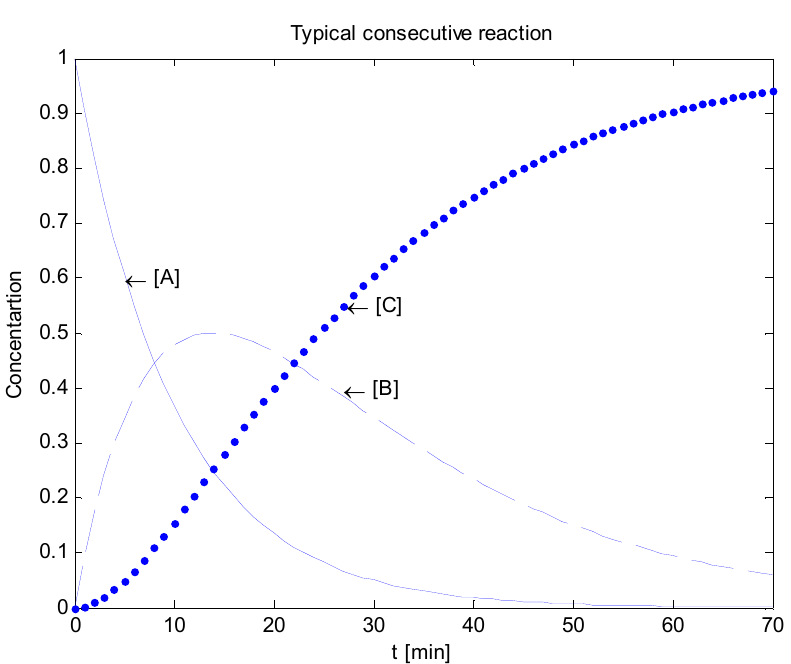
Figure 7. The output voltage ( i.e. , concentration) of elements [ A ], [ B ] and [ C ] as function of